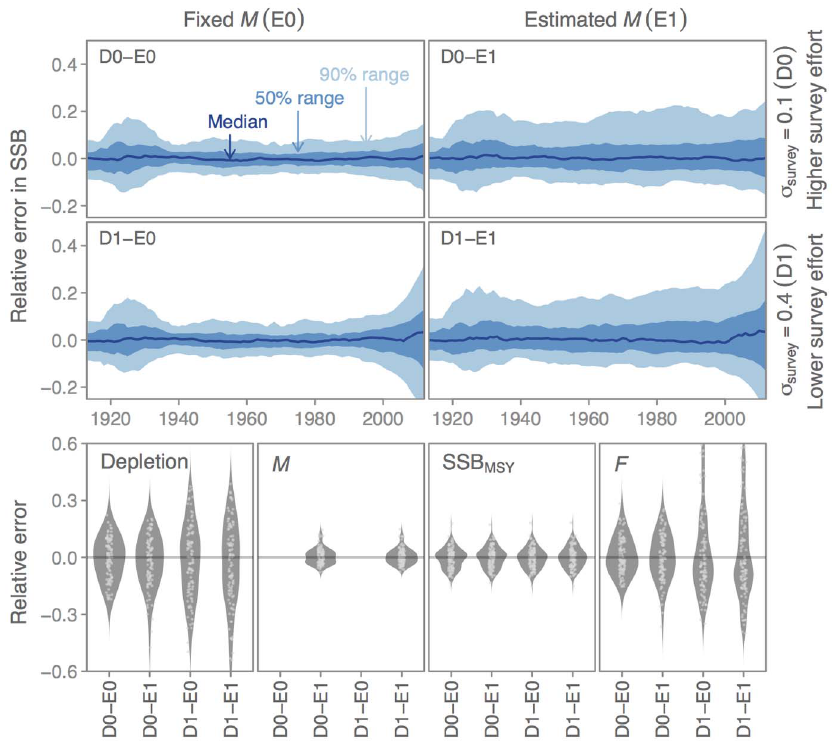
Figure 3. Example output from an ss3sim simulation. We ran a crossed simulation in which we considered (1) the effect of fixing natural mortality ( M ) at its true value (0.2; case E0) or estimating M (case E1) and (2) the effect of high survey effort ( s survey ~ 0 : 1 ; case D0) or low survey effort ( s survey ~ 0 : 4 ; case D1). Upper panels (blue) show time series of relative error in spawning stock biomass (SSB). Lower panels (grey) show the distribution of relative error across four scalar variables: depletion (the ratio of terminal year spawning biomass to unfished spawning biomass), M , SSB at maximum sustainable yield ( SSB MSY ), and fishing mortality ( F ) in the terminal year. We show the values across simulation iterations with dots and the distributions with beanplots (kernel density